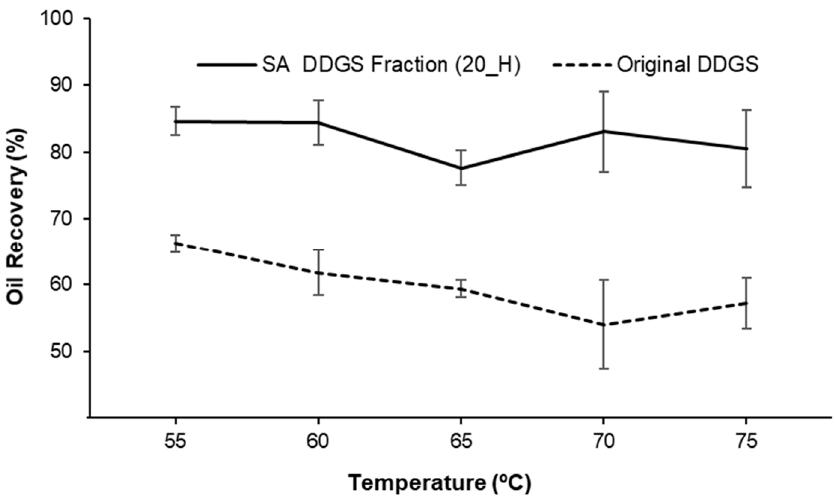
Figure 8. Effect of temperature on oil recovery from sieved aspirated (SA #20), heavy fraction, and original DDGS.